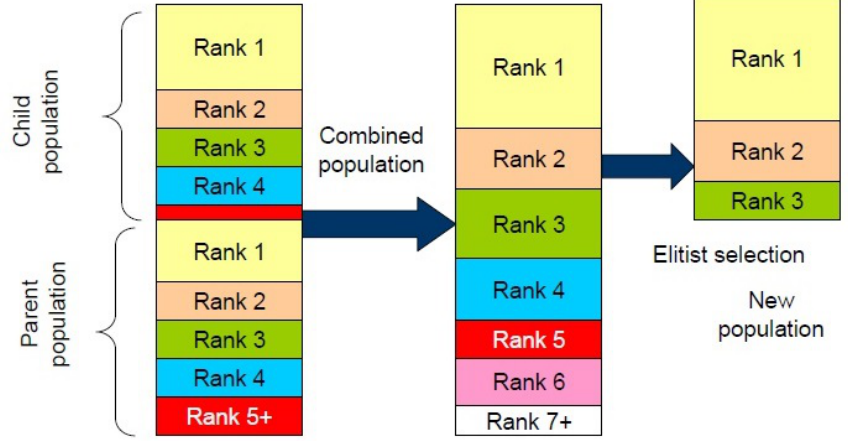
Figure 4. Elitism process of NSGA II.